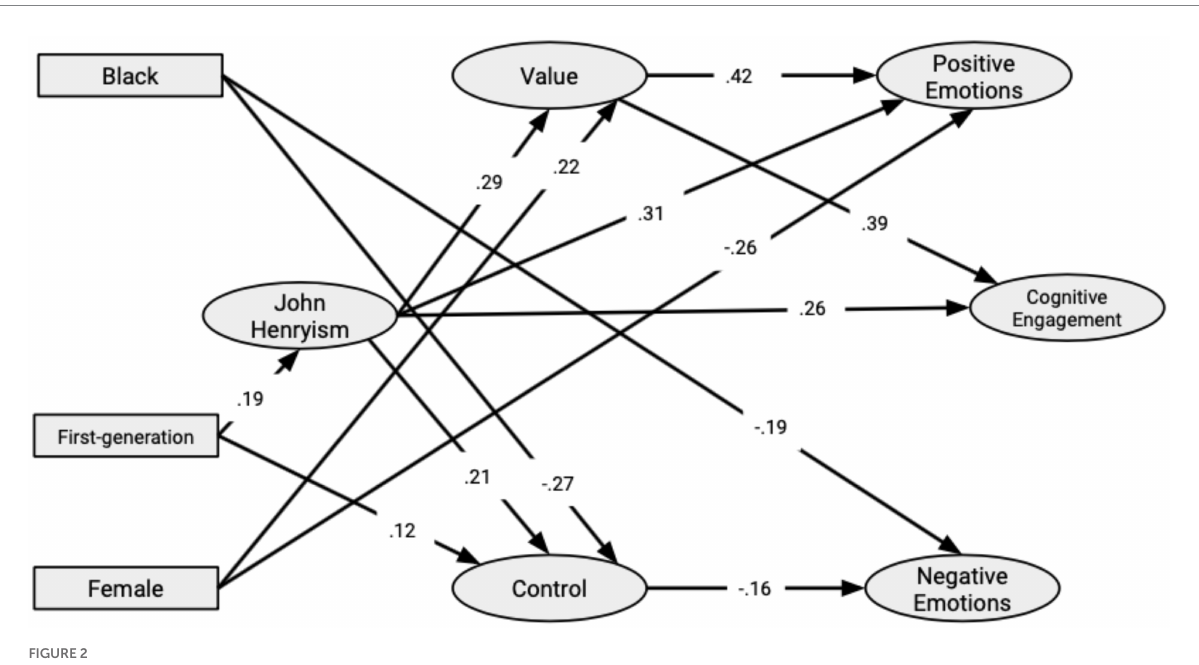
FIGURE 2 Structural equation model with significant direct